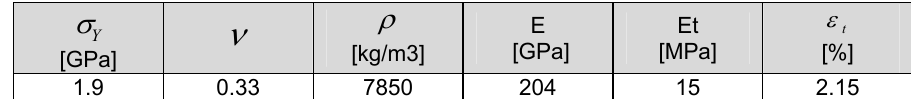
Table 3 – Characteristics of Arne tool steel Таблица 3 – Характеристики инструментальной стали